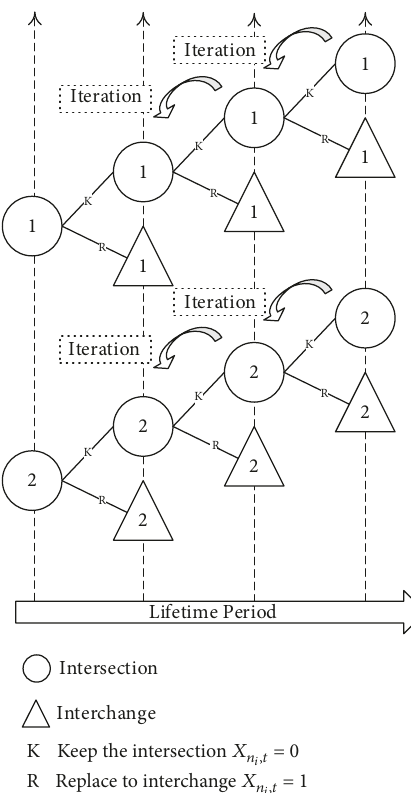
Figure 3: Transition graph of a simplified